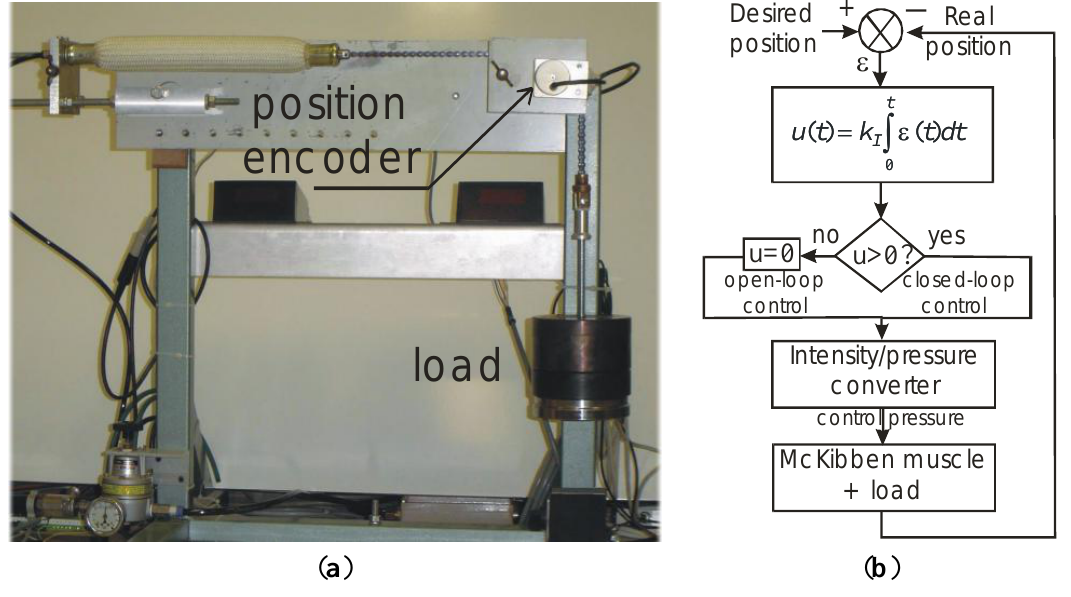
Figure 5. Experimental setup for testing the closed-loop positioning controller of the three considered McKibben pneumatic artificial muscles driving various loads ( a ) and block scheme emphasizing the single-effect character of the McKibben pneumatic artificial muscle ( b )—see